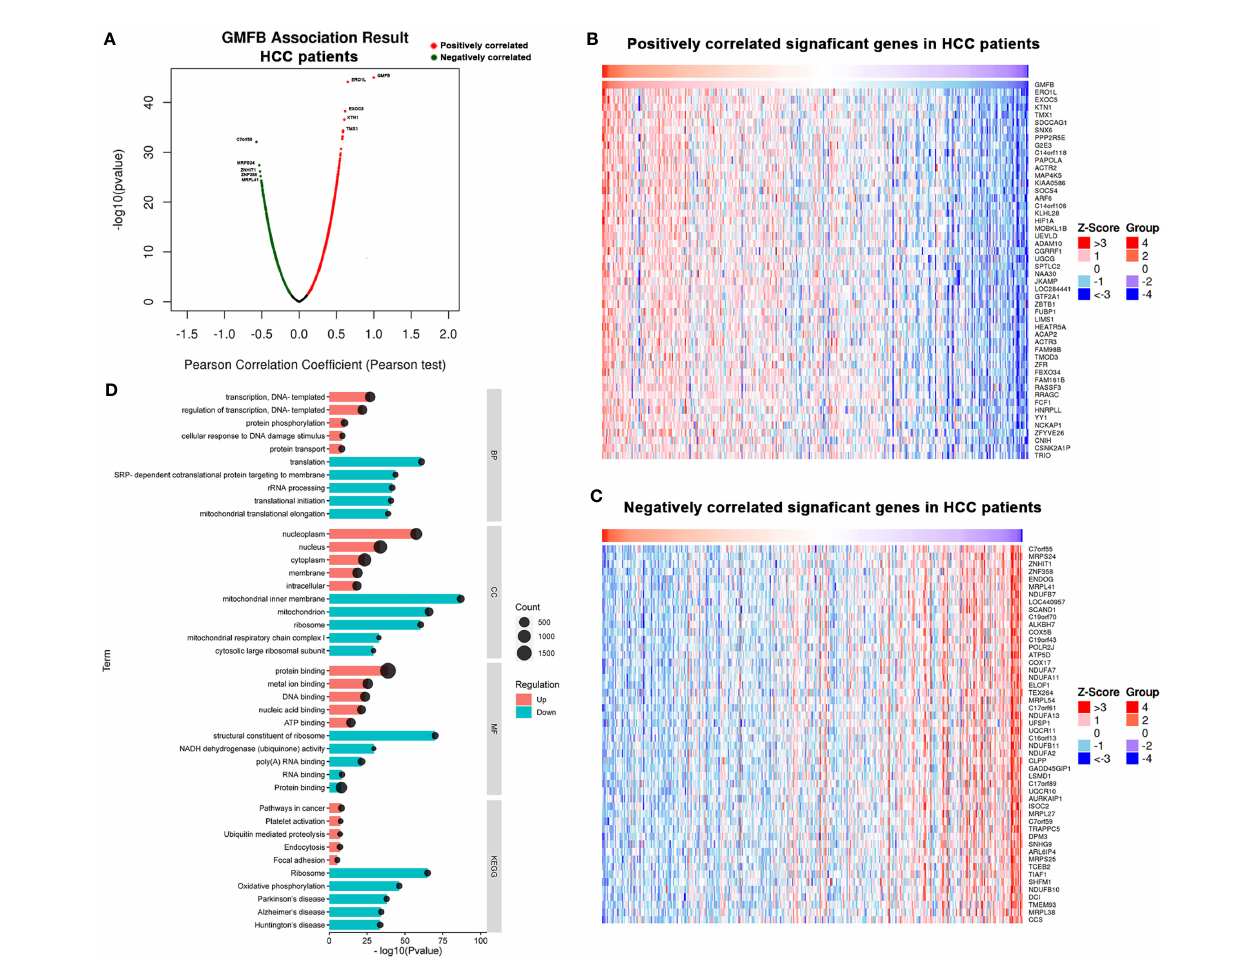
FIGURE 4 | Signi fi cant GO terms and KEGG pathways correlated with GMFB in HCC. (A) A Pearson test was used to identify the correlations between GMFB differentially expressed in HCC cohort (LinkedOmics). Red dots represent positively signi fi cantly correlated genes with GMFB and green dots represent negatively signi fi cantly correlated genes with GMFB. Heat maps showing genes positively (B) and negatively (C) correlated with GMFB in all HCC (TOP 50). (D) Enriched GO terms (BP, CC and MF) and KEGG pathways of upregulated DEGs and downregulated DEGs. Red indicated up-regulation, and green indicated down-regulated. Black circular nodes(count) represent the number of DEGs enriched in each